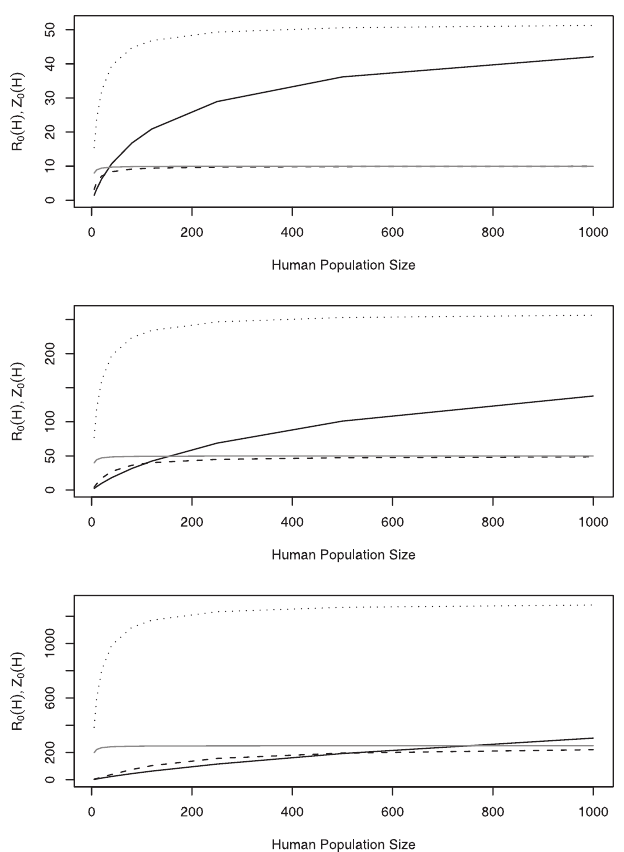
Figure 5. R 0 ( H ) and Z 0 ( H ) in Finite Populations with Heterogeneous and Uniform Biting at Three Biting Intensities The three biting intensities shown are for an R 0 for homogenous biting equal to 10 (top), 50 (middle), and 250 (bottom). R 0 ( H ) rises slowly to R 0 , as a function of H, whether biting rates are heterogeneous (solid black lines) or uniform (dashed lines). Surprisingly, R 0 ( H ) for heterogeneous biting is lower than that for uniform biting, especially when H is low and R 0 is high. By contrast, Z 0 ( H ) rises rapidly to R 0 as a function of human population size, H, when biting rates are heterogeneous (dotted lines) or completely uniform (grey lines). These effects occur at population sizes well below those where the transmission-reducing effects of urban- ization are evident